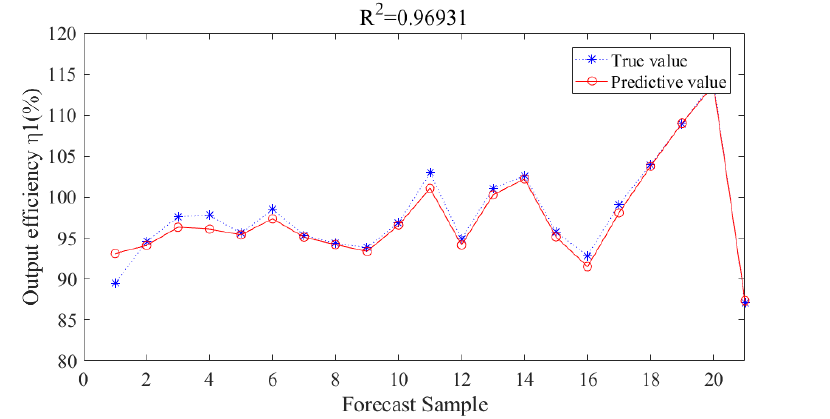
Figure 15. Training results of complexity prediction model of function unit of separate TCM.